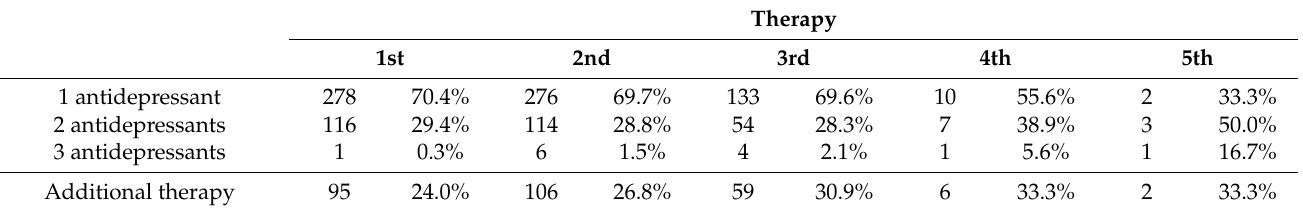
Table 3. Medications used in each therapy.